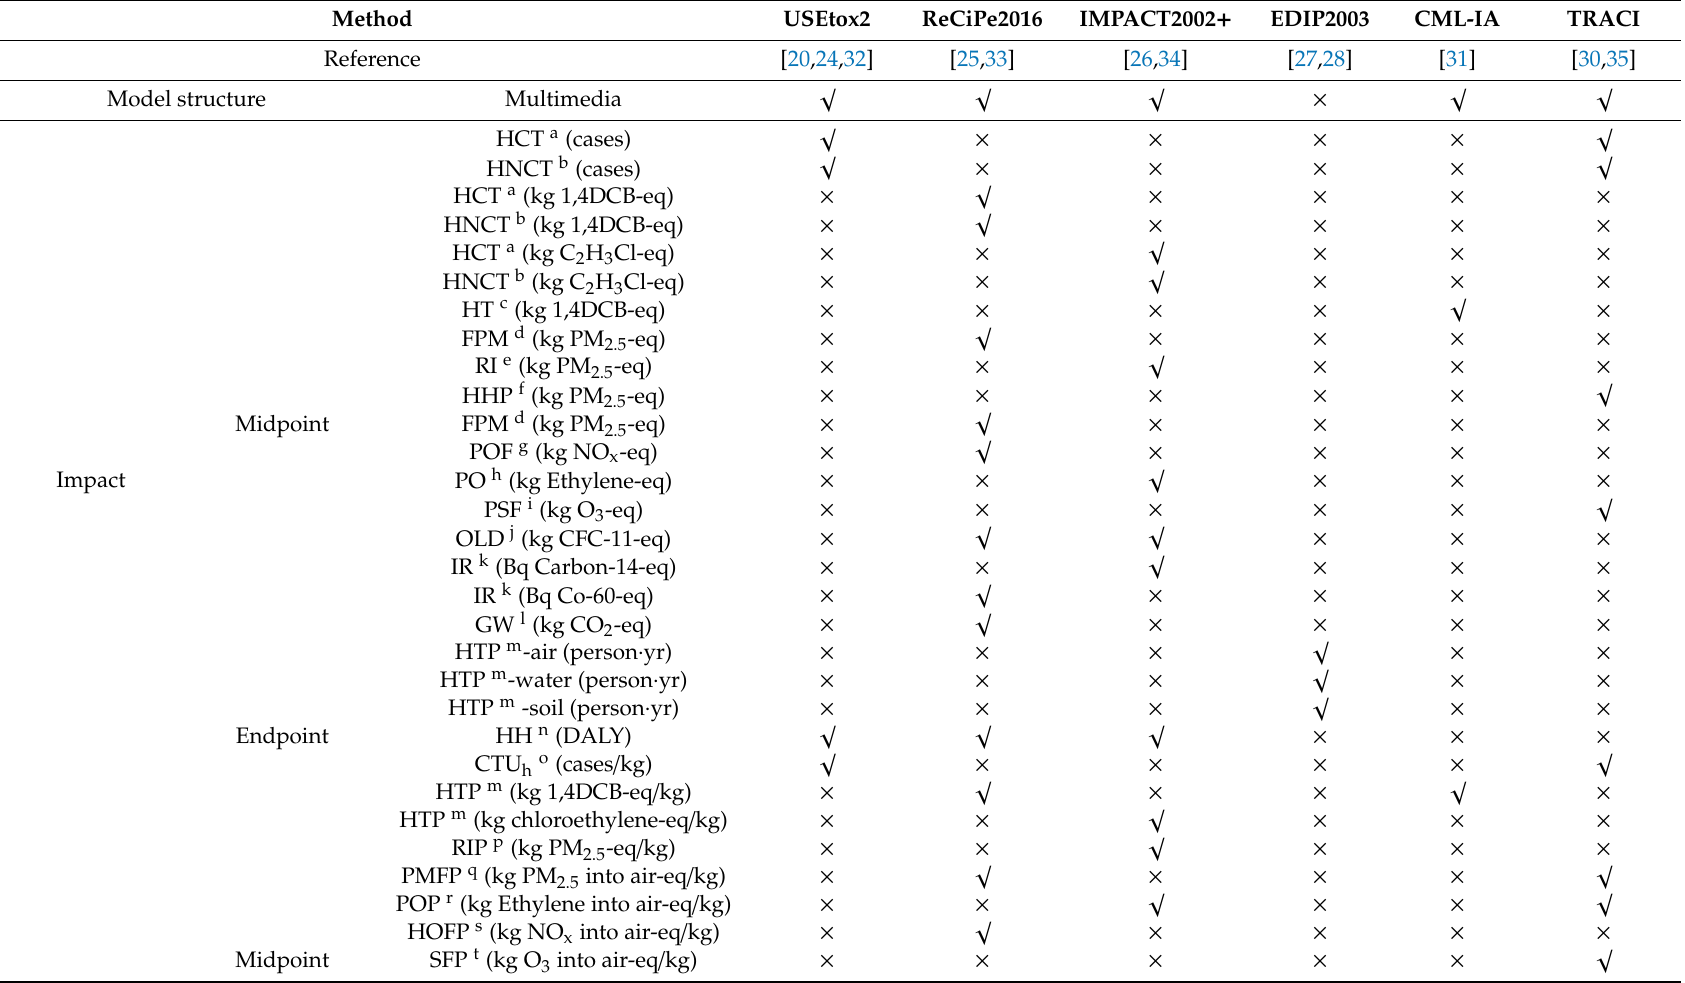
√ Table 1. Main features of di ff erent LCIA methods ( : the method considers the feature described; × : the method does not consider the feature